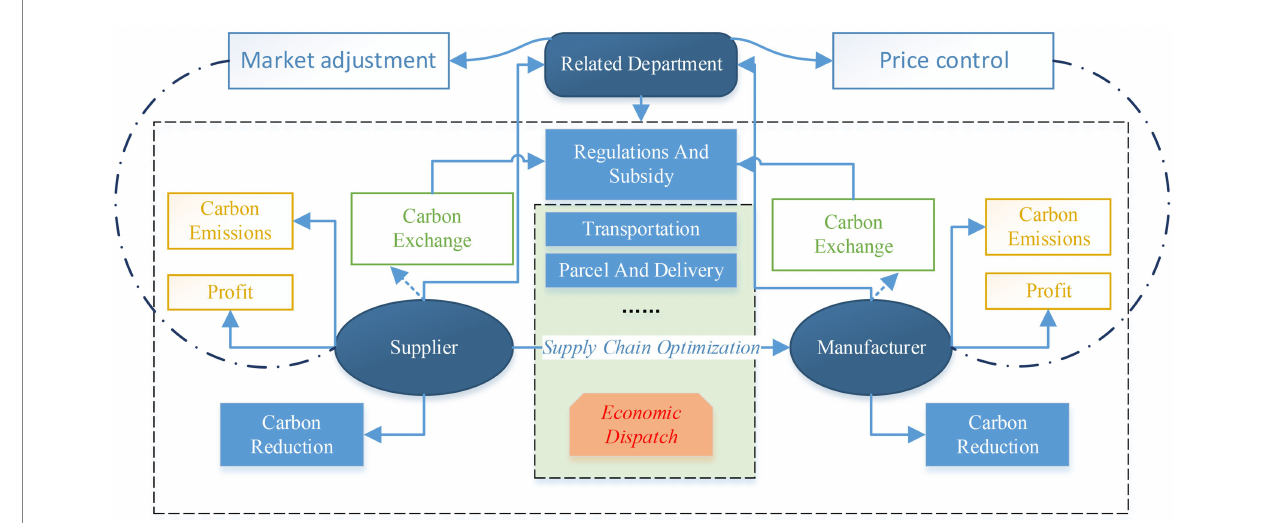
FIGURE 2 The dispatch in the low-carbon